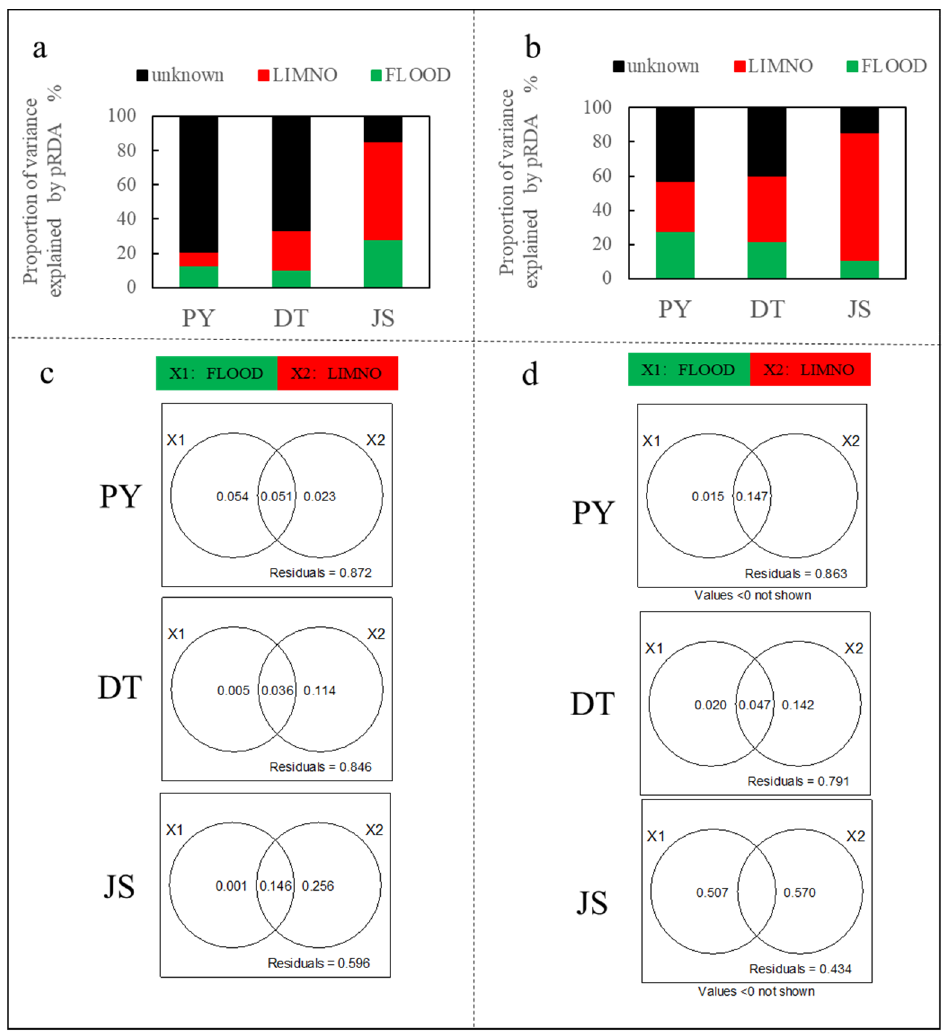
Figure 4. Partial redundancy analysis between zooplankton biomass and 16 environmental variables during the high water level ( a / c ) and low water level seasons ( b / d ) conducted for lake Poyang (PY), L. Dongting (DT), and L. Junshan (JS). The variation explained by environmental variables are displayed with the percentage stacking charts ( a , b ) and the Venn diagrams ( c , d ).